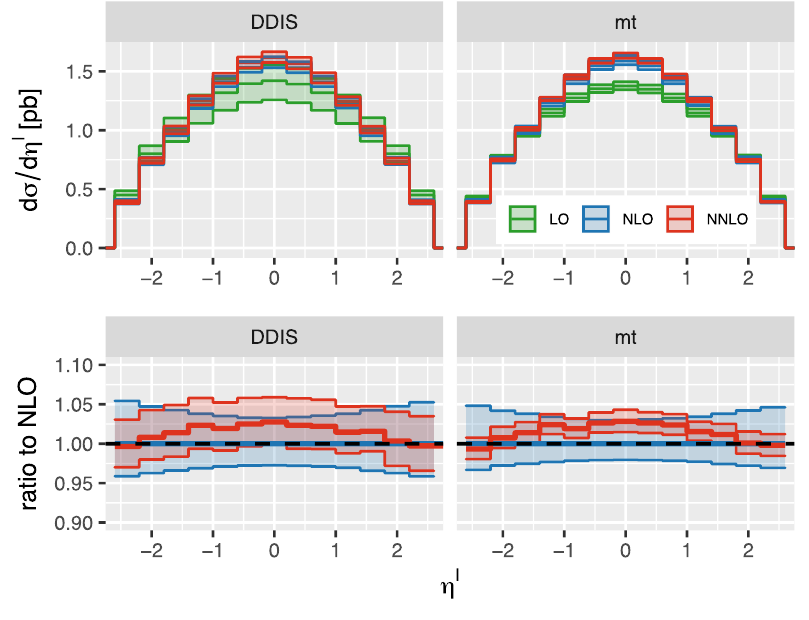
Figure 10 . Pseudorapidity distribution of the charged lepton with DDIS scales (left) and fixed scale m t (right).